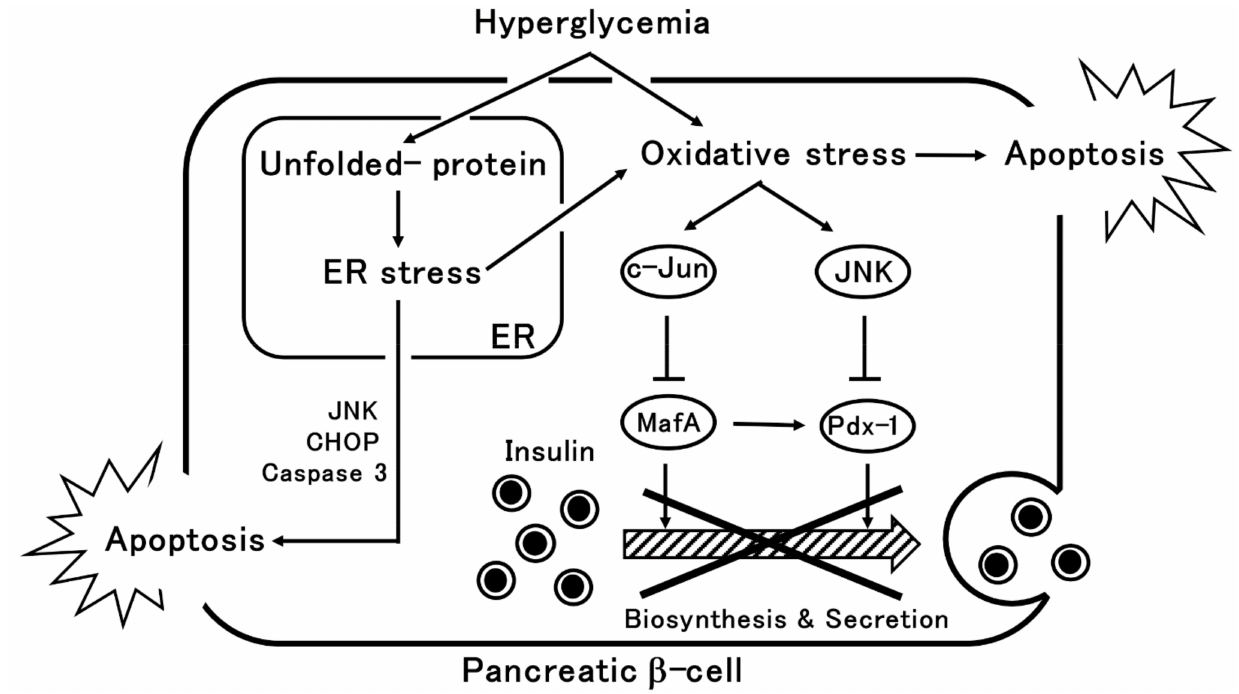
Figure 1. Mechanisms of pancreatic β -cell damage due to hyperglycemia. In chronic hyperglycemia, oxidative stress induces a decrease in the expression of MafA and Pdx-1, which are important transcription factors for the regulation of insulin gene expression, through c-Jun and JNK, resulting in decreased insulin biosynthesis and secretion. Oxidative stress induces apoptosis. Chronic hyperglycemia induces ER stress through the accumulation of unfolded proteins, leading to the apoptosis of pancreatic β -cells. Arrows indicate promotion and T arrows indicate